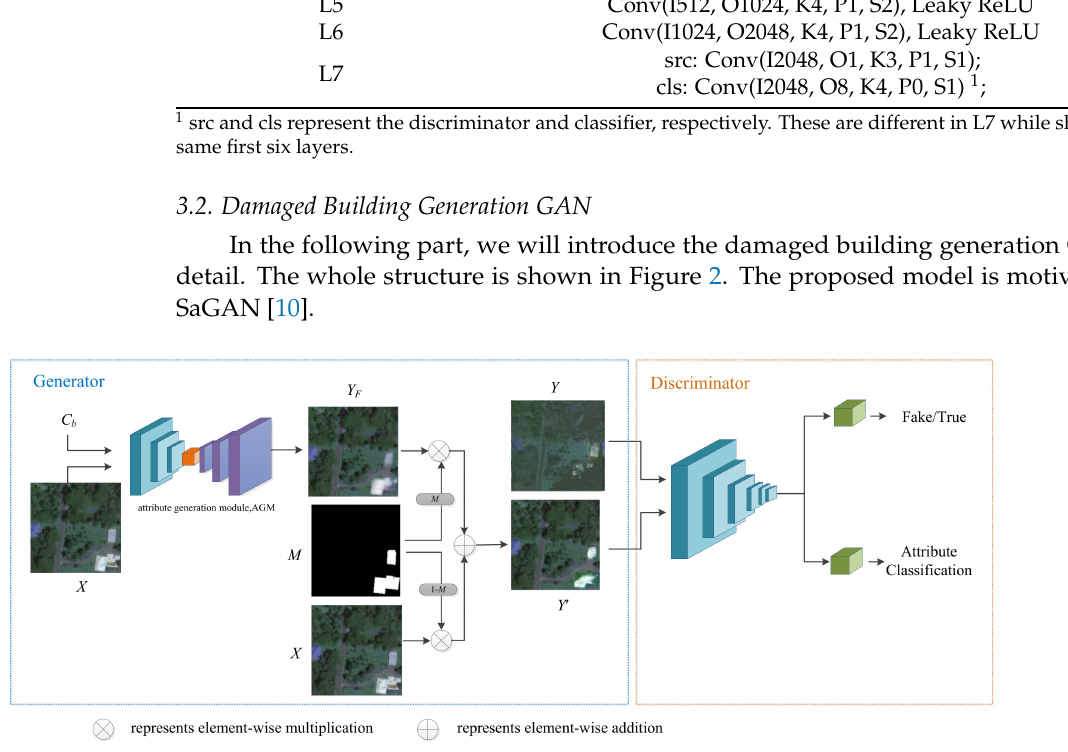
Figure 2. The architecture of damaged building generation GAN, consisting of a generator G and a discriminator D . D has two objectives, distinguishing the generated images from the real images and classifying the building attributes. G consists of an attribute generation module (AGM) to edit the images with the given building attribute, and the mask-guided structure aims to localize the attribute-specific region, which restricts the alternation of AGM within this